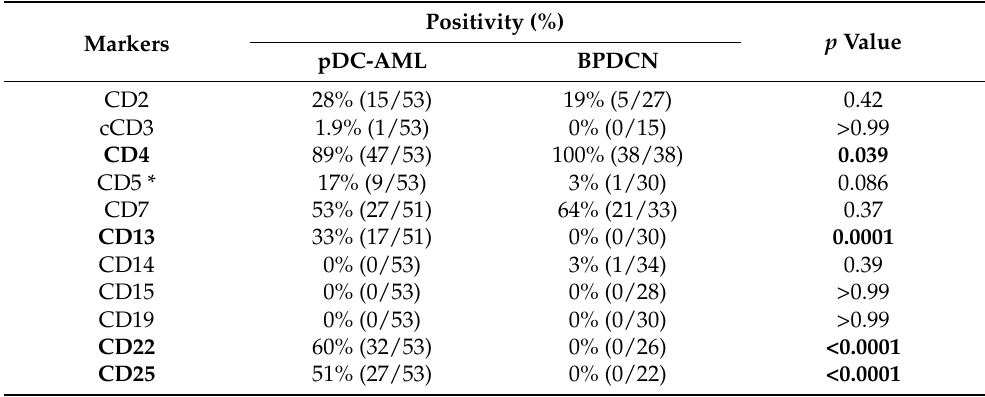
Table 1. The immunophenotype of pDCs in pDC-AML ( n = 53) and BPDCN ( n =